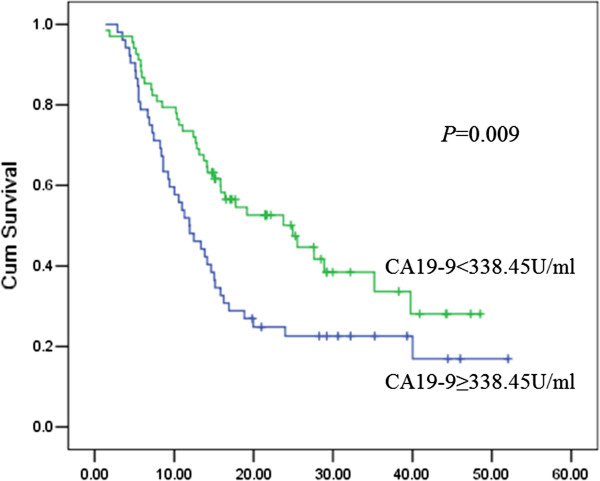
Comparison of the overall survival between the two groups separated by the CA19-9 cutoff value of 338.45 U/mL. A significant difference in survival was revealed by the log-rank test (P = 0.009).